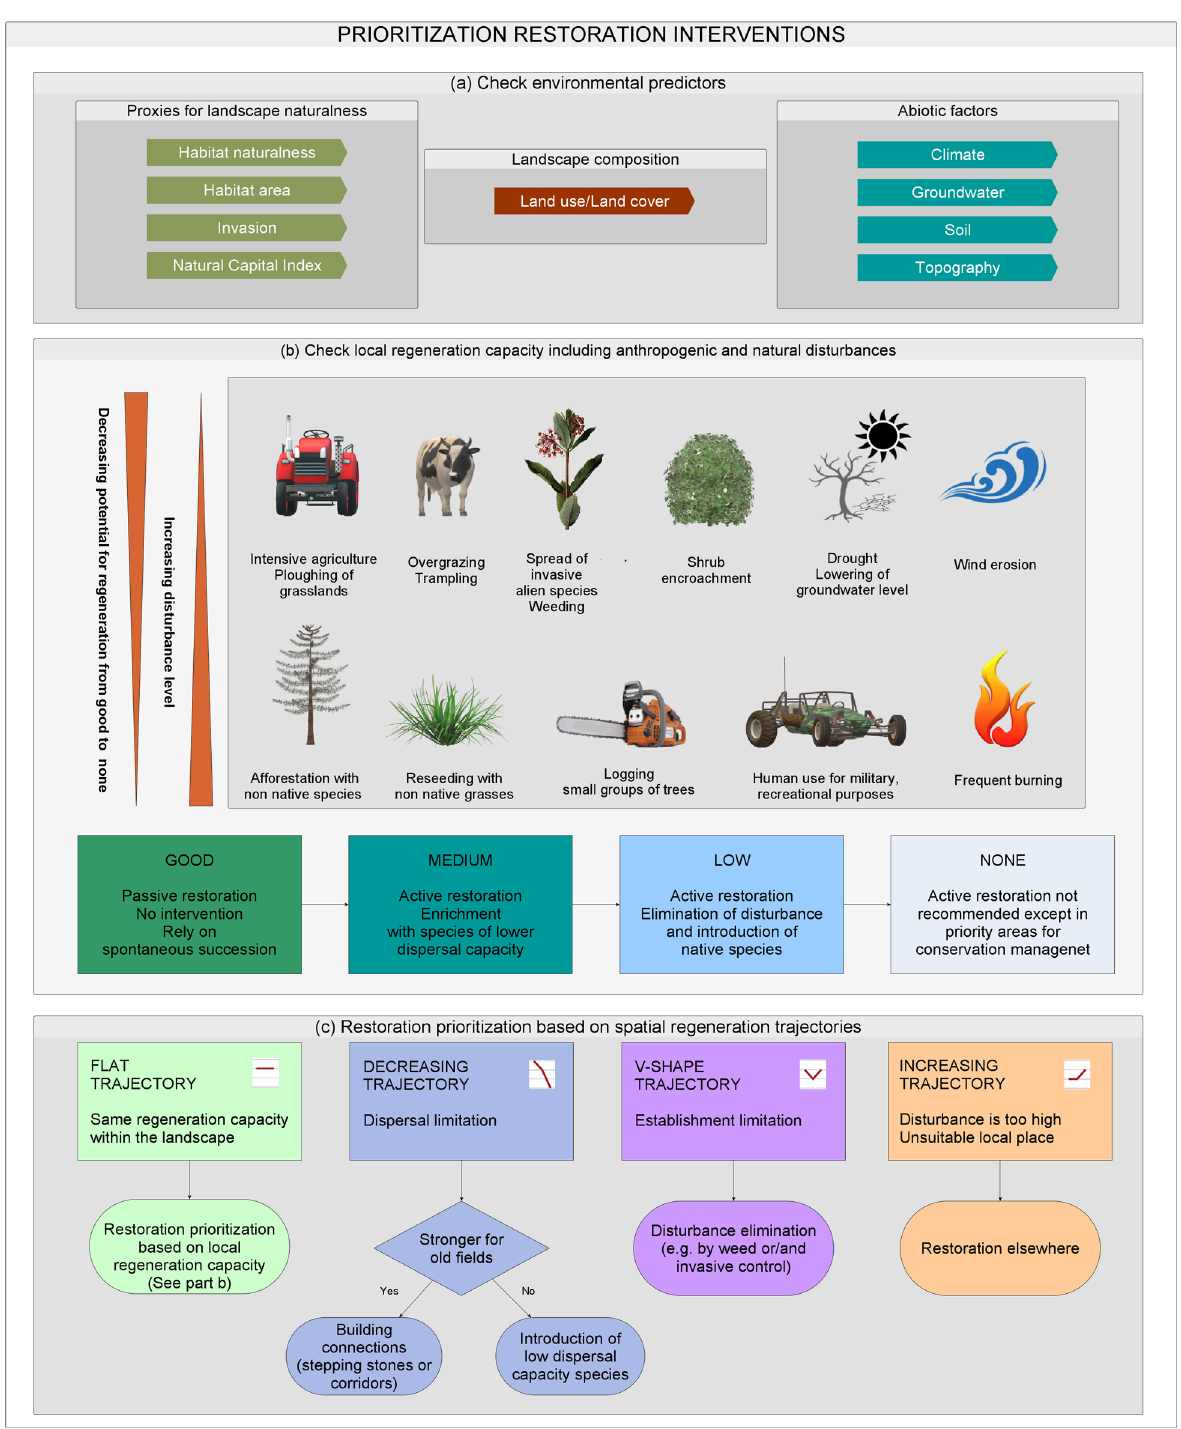
Fig. 3 Conceptual diagram of prioritizing restoration interventions in the sandy habitat types. a Studied environmental predictors, b restoration prioritization based on the local regeneration capacity including anthropogenic and natural disturbances, and c restoration prioritization based on the spatial regeneration trajectories. (The icons in Fig. 3b were created using Microsoft Paint 3D